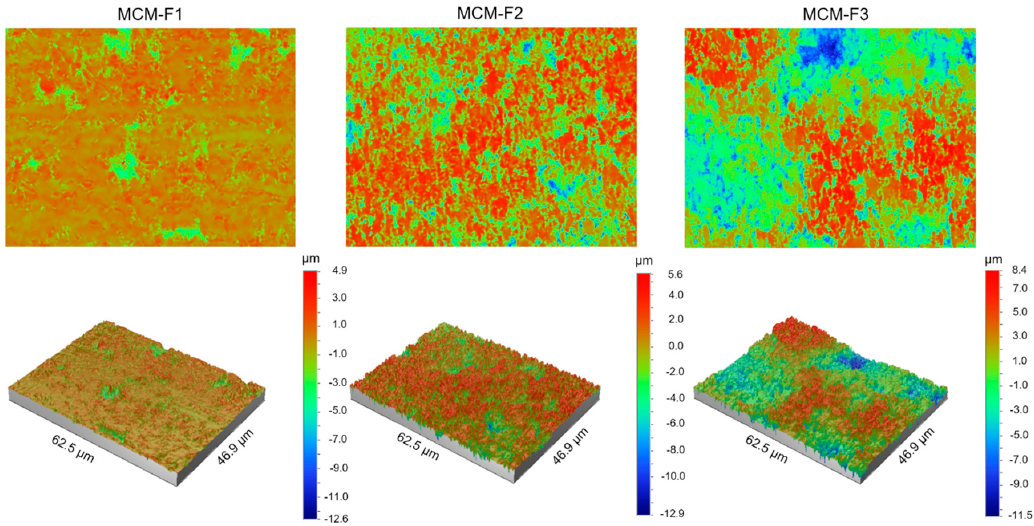
Figure 3. The optical profilometer images of 62.5 µm × 46.9 µm surfaces of MCM ‐ F1, MCM ‐ F2, MCM ‐ F3 solid films.